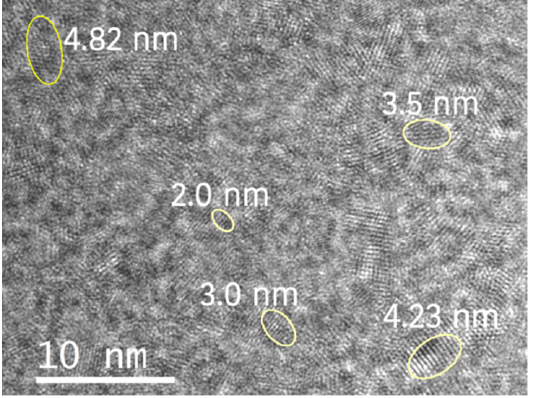
Figure 4. TEM image of nanoceria extracted from S5NBCe4 glass by dissolving in DI water for two hours. The marked crystals and their width is shown in the figure.